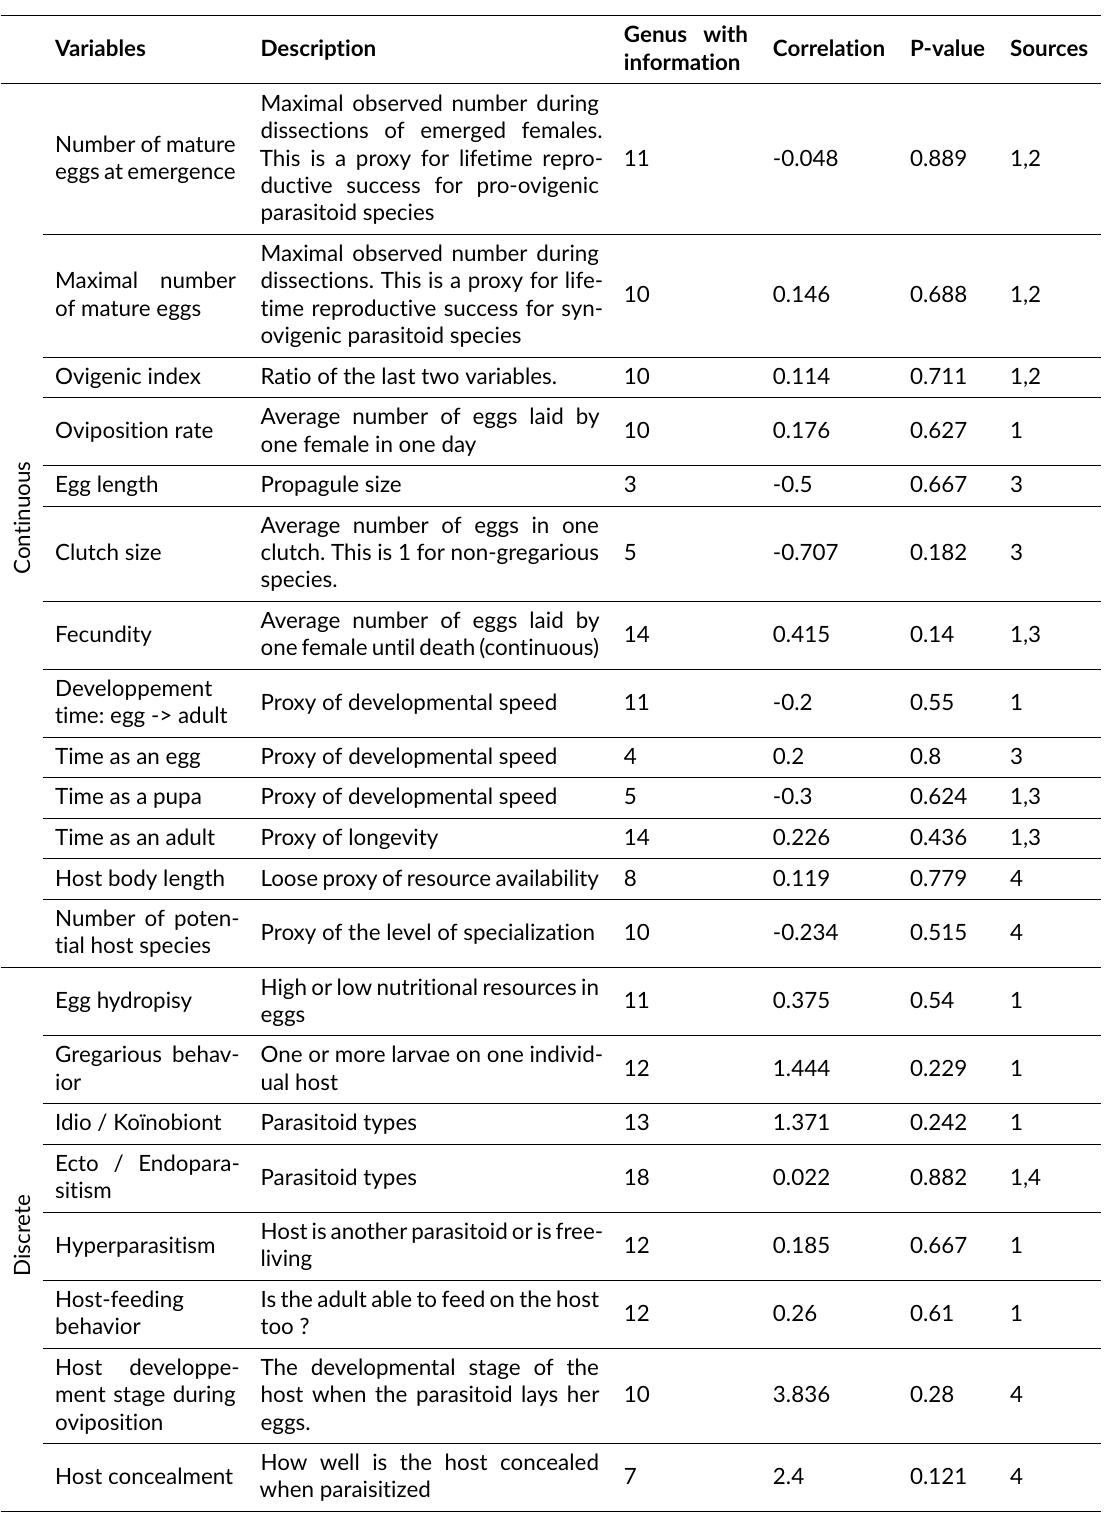
Table S1 – Life-history and specialisation descriptors for parasitoids. Tested variables and their description are displayed along with the value of the statistic obtained for each correlation test with corrected dN/dS ratios. Correlation tests are Spearman tests for continuous variables and Kruskal-Wallis tests for discrete variables. Sources are 1: Jervis and Ferns (2011), 2: Mayhew (2016), 3: Traynor and Mayhew (2005a), 4: Traynor and Mayhew